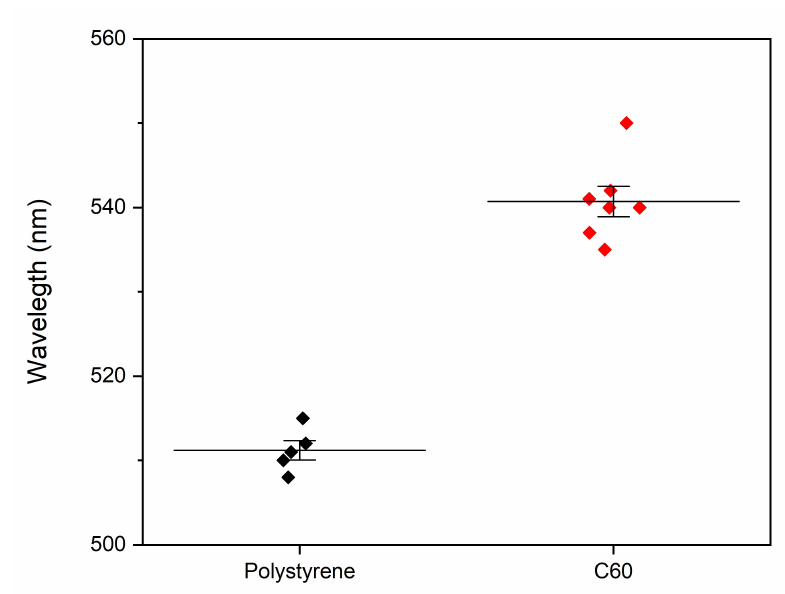
Figure 4. Comparison of Au SPR peaks in PS and C 60 cavities.